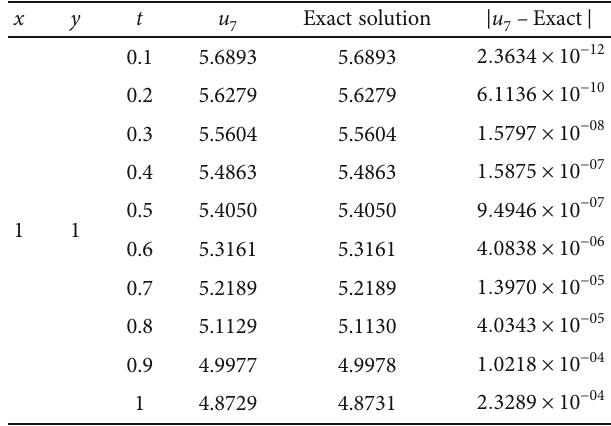
Table 5: Seventh-order approximate solution by RDTM of Example 4 for di ff erent values of t and comparison with the exact